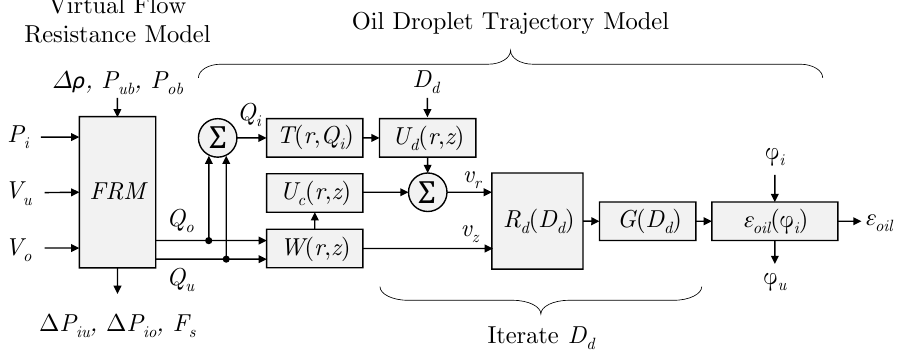
Figure 5. Block diagram of the proposed hydrocyclone model, where T , U c , and W are tangential, radial, and axial velocity fields, respectively [17,55,57]. R d is the starting radius of a critical droplet trajectory. ϕ i and ϕ u are the inlet and underflow volumetric droplet size distribution,